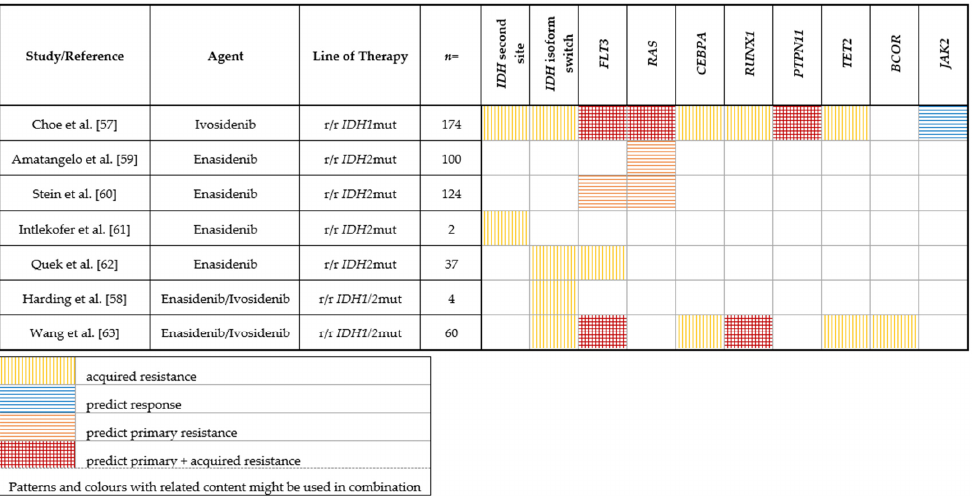
Table 2. Mutations associated with response or resistance to IDH1/2